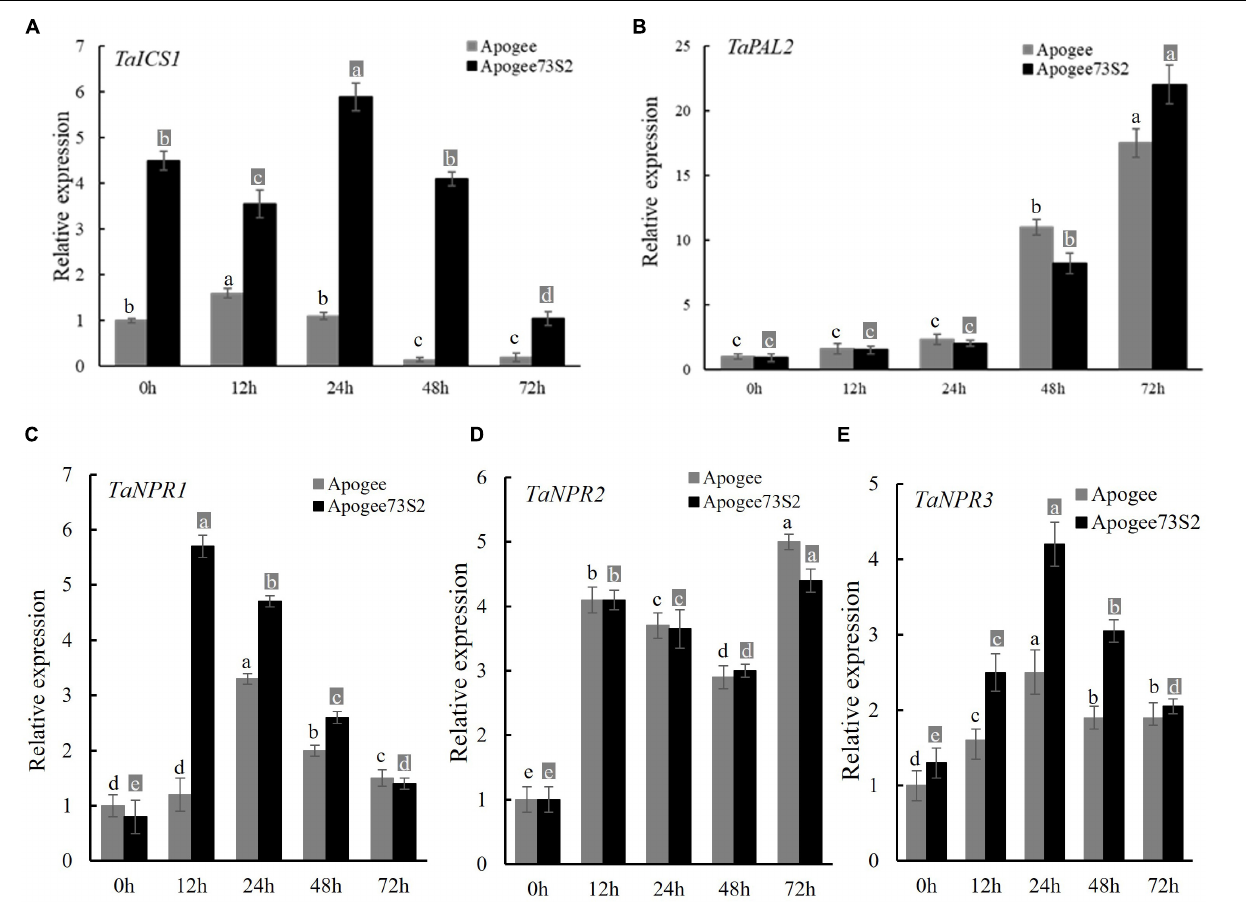
FIGURE 5 | Expression of TaICS1 (A) and TaPAL2 (B) for SA synthesis, and TaNPR1 (C) , TaNPR2 (D) , and TaNPR3 (E) for SA signaling transduction in the spike of the Apogee (Fhb1 susceptible NIL) and Apogee73S2 (Fhb1 resistant NIL) at 0, 12, 24, 48, and 72 h after inoculation with F. graminearum PH1-1. Error bar shows standard deviation. Different letters on the top of each bar in the same color (dark or light) indicate significant differences at p = 0.05 (LSD) among relative expressions at inoculation time